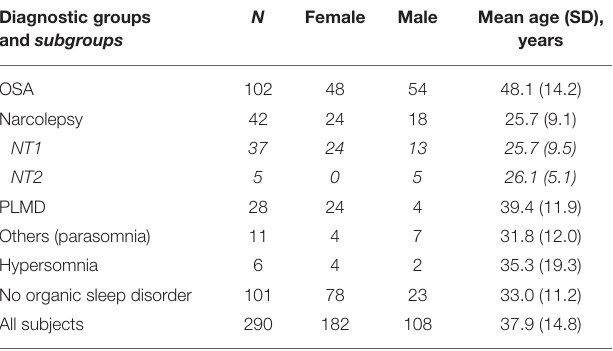
TABLE 1 | Diagnostic groups and subgroups.